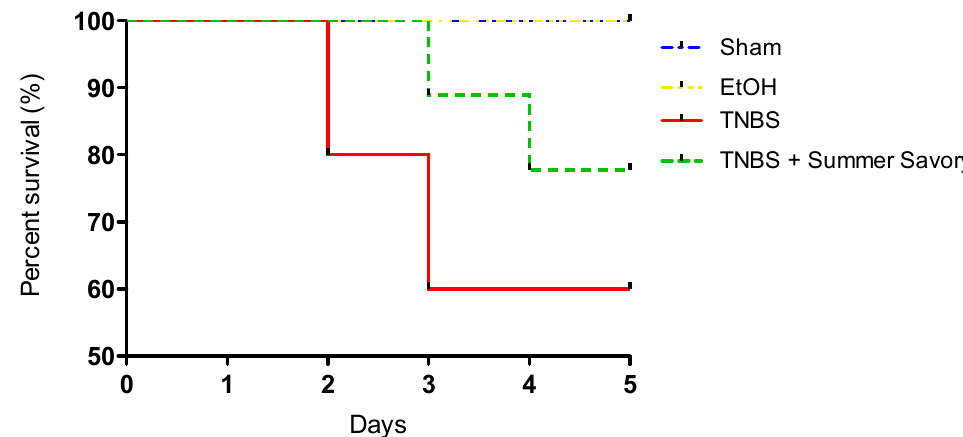
Figure 7. Kaplan–Meier analysis of survival in the colitis model. Sham Group ( n = 6); EtOH Group ( n = 6); TNBS + EtOH Group ( n = 10); TNBS + Summer Savory Group ( n = 10).